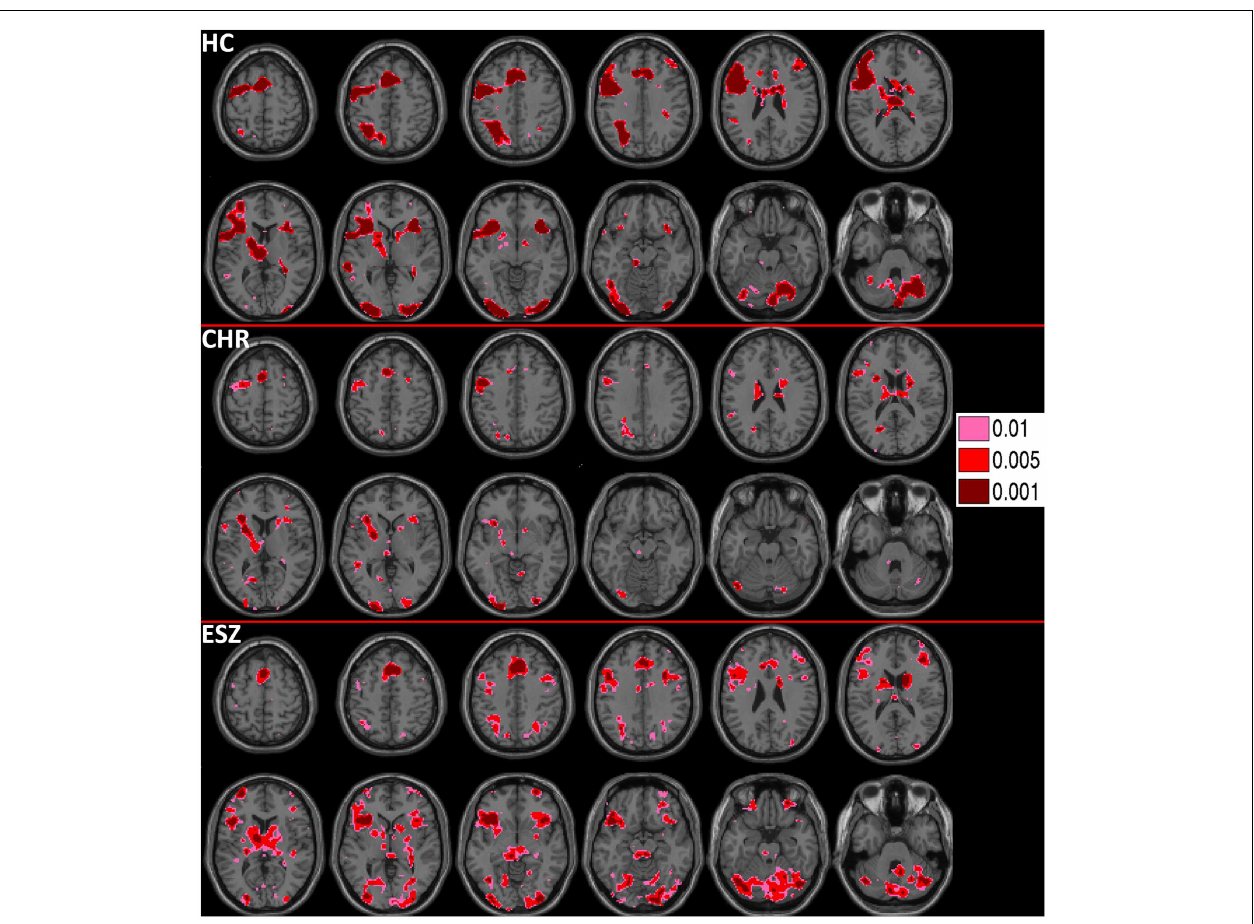
load are shown in hot colors at three uncorrected height thresholds ( p < 0.01, p < 0.005, and p < 0.001), and include left dorsolateral prefrontal cortex and dorsal anterior cingulate cortex. Extent of axial montage is 58mm > Z > − 30mm, with an 8-mm